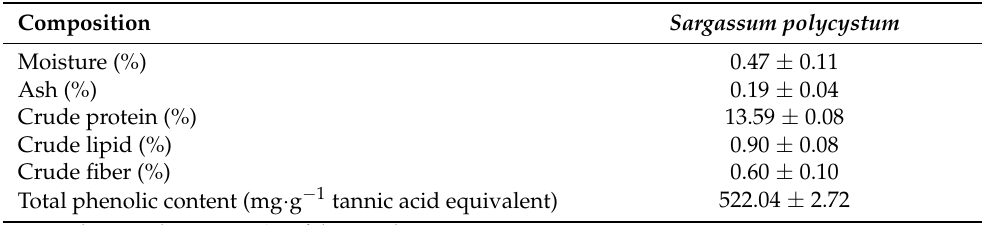
Table 1. Proximate composition of hot-water extract from Sargassum polycystum